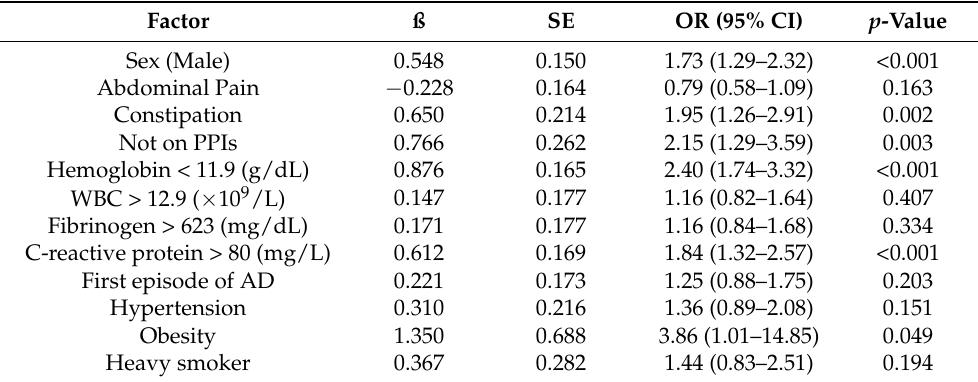
Table 2. Multivariate analysis (logistic regression) for factors associated with complicated